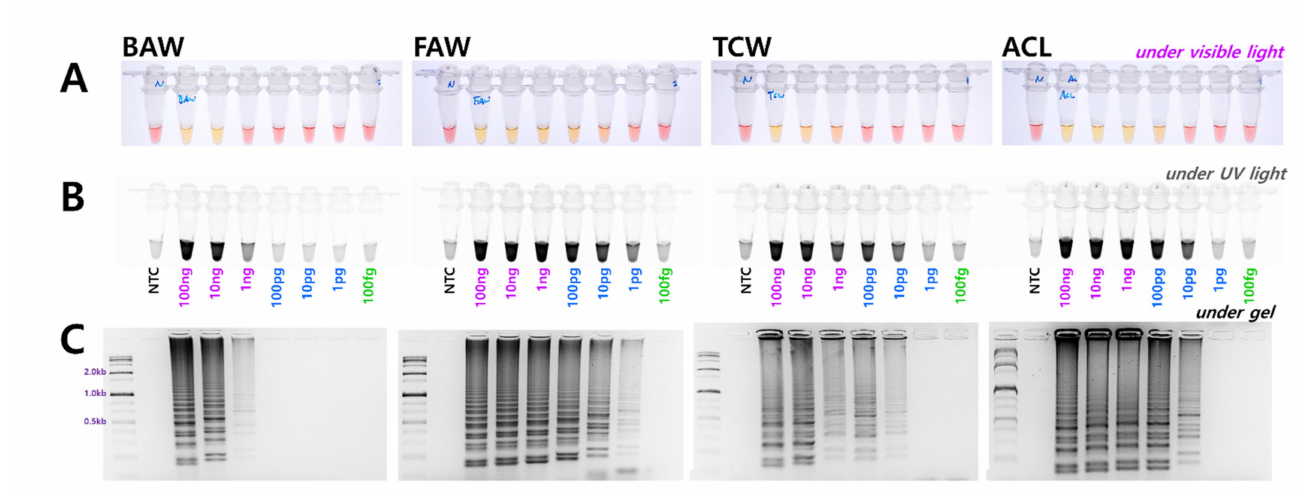
Figure 3. Identification of the genomic DNA detection limit in the four Spodoptera species diagnostic LAMP assay from 100 ng to 100 fg using four LAMP primers under ( A ) visible light, ( B ) ultraviolet light with SYBR Green, and ( C ) gel electrophoresis. NTC: no template control.